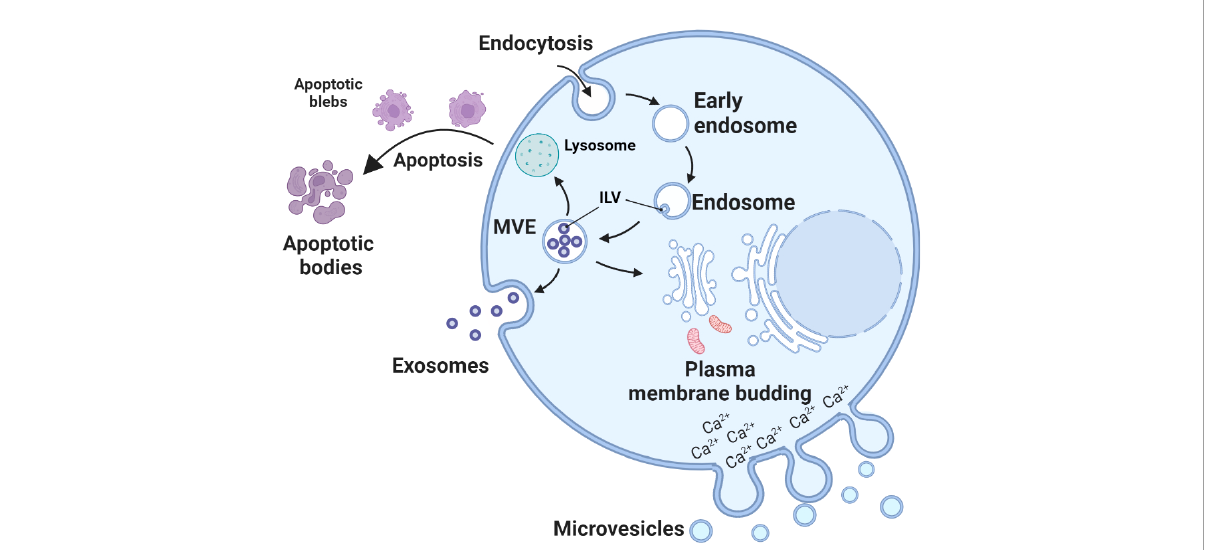
FIGURE 1 Biogenesis of urinary extracellular vesicles (uEVs). Exosome biogenesis starts from inward budding of the plasma membrane (endocytosis) and eventual formation of early endosomes. The membranes of early endosomes invaginate and bud into surrounding luminal space with cytoplasmic content to form intraluminal vesicles (ILVs) (29). Late endosomal structures containing ILVs are known as multivesicular endosomes (MVEs), which are eventually transported to the trans-Golgi network for endosome recycling, delivered to lysosomes for degradation of all carried material, or fuse with the plasma membrane and release exosomes outside the cell (30). Microvesicles arises through outward budding and fi ssion of plasma membrane and is the result of dynamic interplay between phospholipid redistribution and cytoskeletal protein contraction (31, 32). Apoptotic bodies are formed during apoptosis. Apoptosis progresses through several stages, fi rst nuclear chromatin condensation, then nuclear splitting and the frequent appearance of micronuclei, then membrane blebbing and fi nally splitting of the cellular content into distinct membrane-enclosed vesicles, termed apoptotic bodies (33,